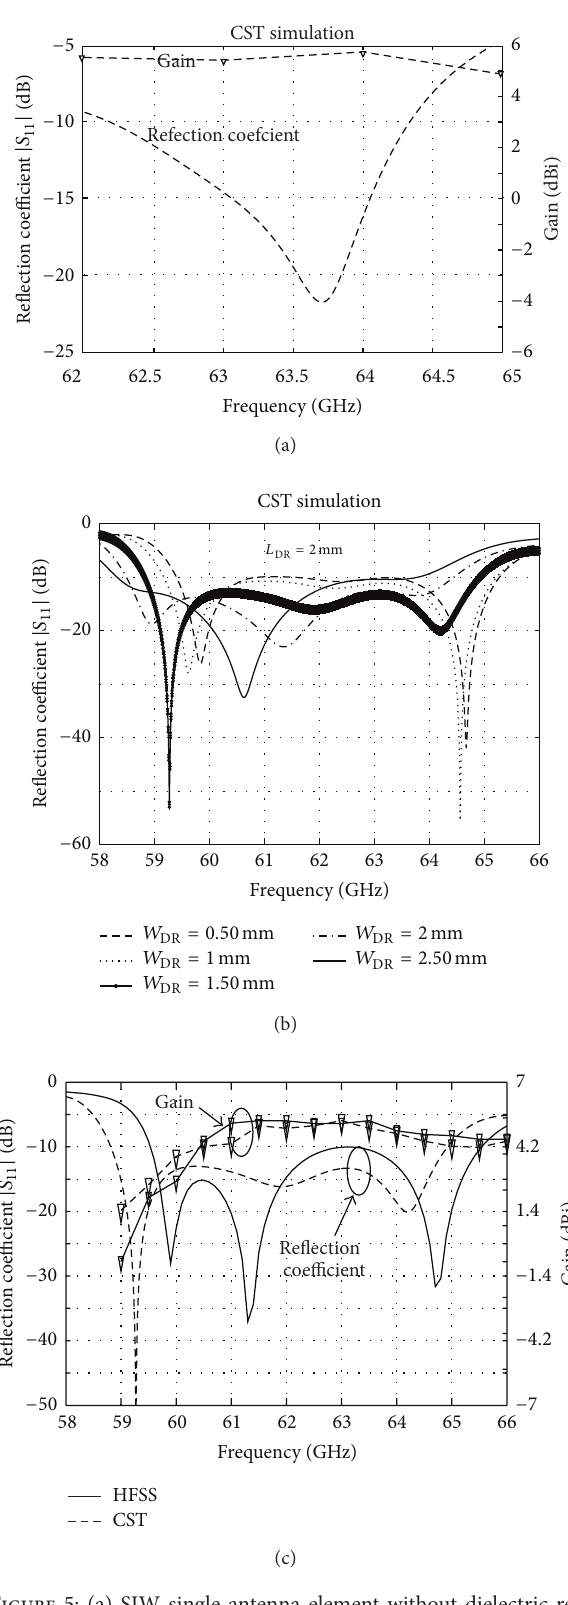
Figure 5: (a) SIW single antenna element without dielectric res- onators (DR), (b) dielectric resonators (DR) parameter optimiza- tion, and (c) SIW single antenna element with dielectric resonator